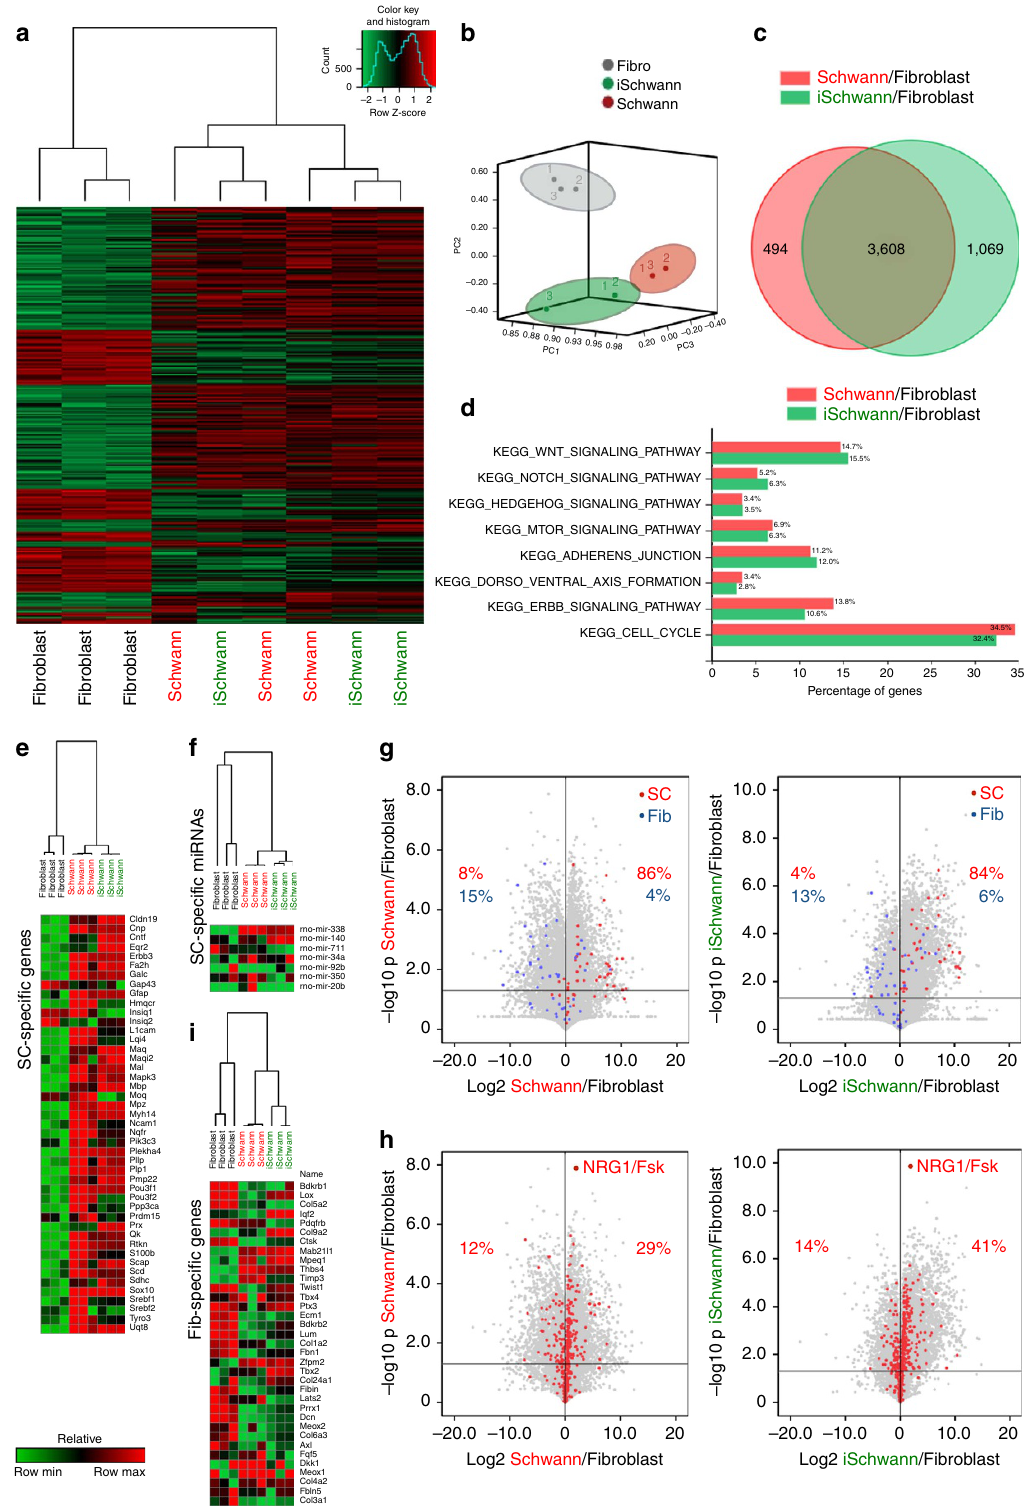
Figure 2 | Comparative transcriptomic analysis of iSCs, primary SCs and fibroblasts of origin. ( a ) Heat-map of the unsupervised hierarchical clustering (UHC) of 2,500 random genes for fibroblasts and somatic and induced Schwann cells. The correlation between samples is shown as a dendrogram on top of the picture. ( b ) Principal component analysis showing the first three components, explaining about 75% of the total variance. ( c ) Venn diagram showing the overlap between the differentially expressed genes (DEGs) comparing Schwann and iSchwann cells versus fibroblasts. ( d ) Functional enrichment analysis of the DEGs. ( e , f ) UHC of somatic SC-specific genes/microRNAs in the three cell populations. ( g ) Volcano plots showing the distribution of SC- and fibroblast-specific genes in the two conditions. (Chi-square test SC-specific genes P ¼ 0.94; Chi-square test fibroblast-specific genes P ¼ 0.81) ( h ) Volcano plots showing the distribution of the genes perturbed upon exposure to NRG1/Fsk in the two comparisons (Chi-square test P ¼ 0.82). ( i ) UHC of fibroblast-specific genes in the three cell